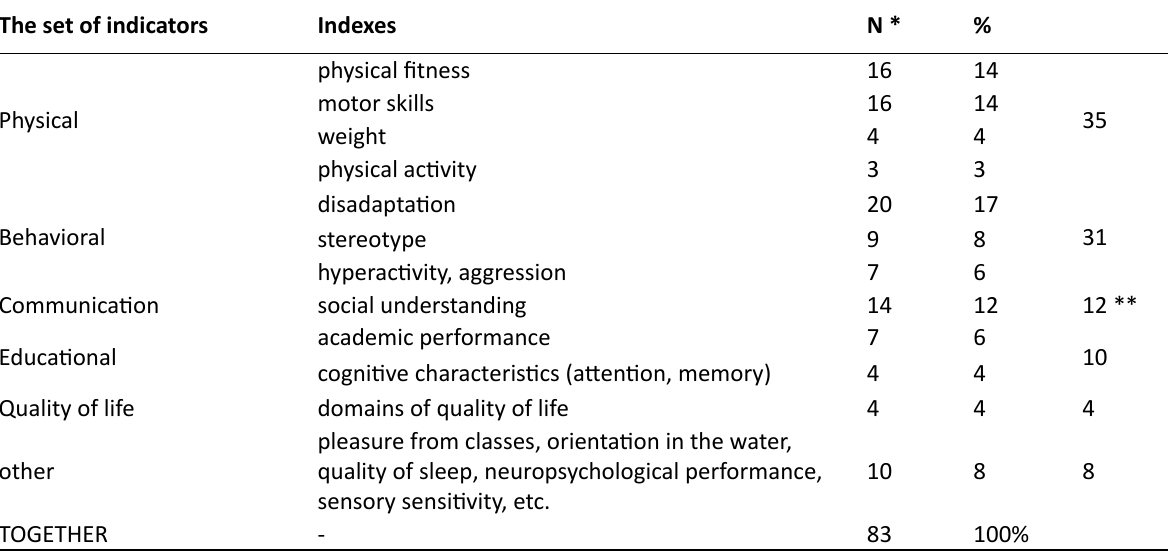
Table 1. The frequency of study of parameters during the study of the effectiveness of means in physical education of children with autistic spectrum disorders (N = 48) The set of indicators